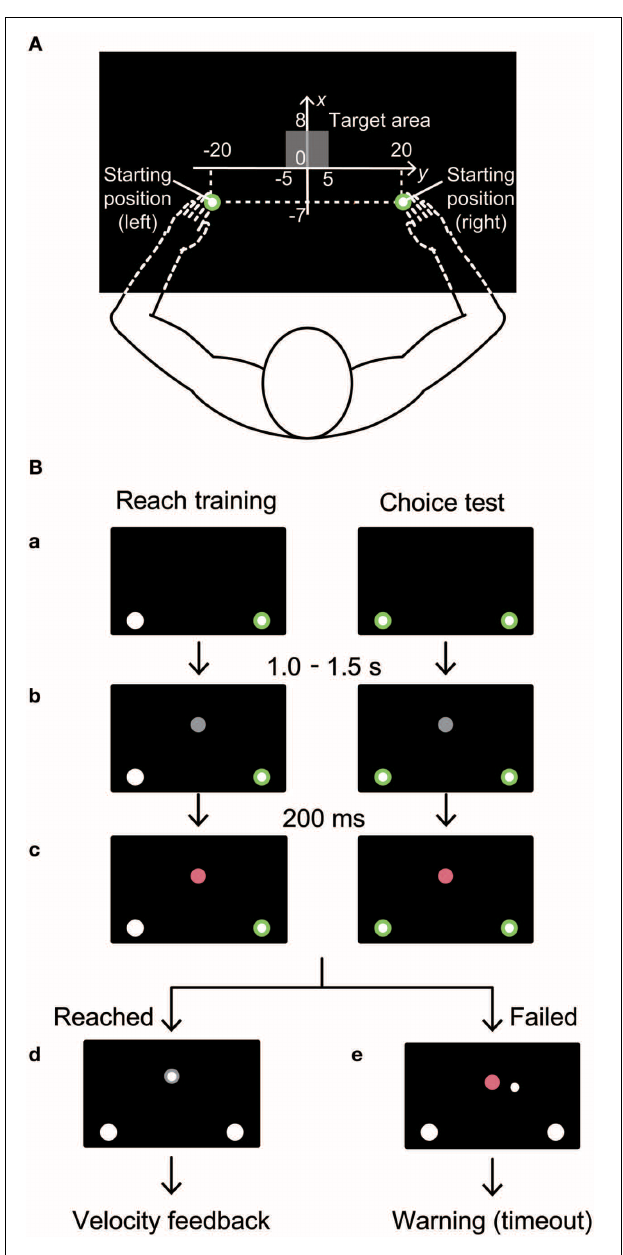
FIGURE 1 | (A) Experimental procedures for the reach training and the choice test tasks. The origin of the frame of reference for the display was set at the midpoint of the fingertips when the elbow angle was 90 ◦ and the shoulder angle was 30 ◦ (full extension was 0 ◦ ). The starting position for the left hand: ( x , y ) = ( − 20 . 0 cm , − 7 . 0 cm ) . The starting position for the